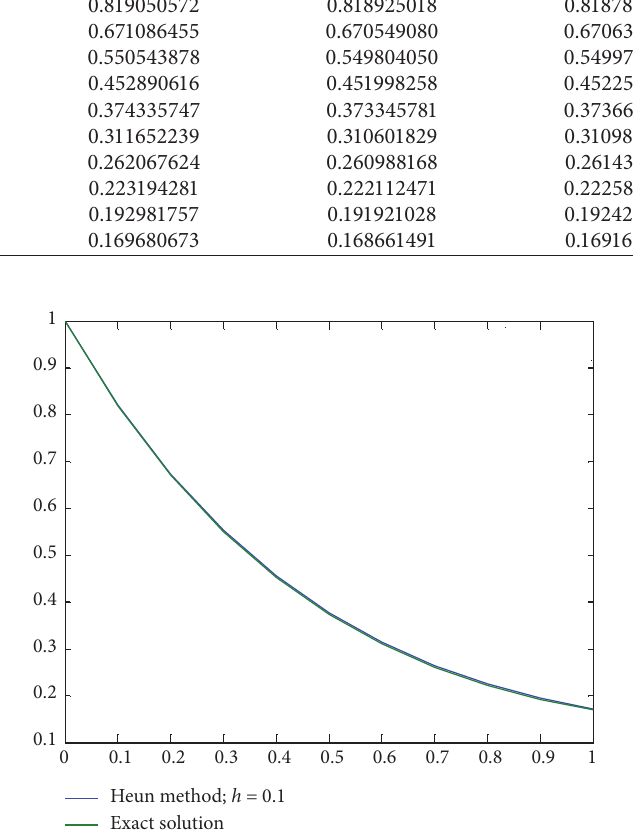
Figure 2: Numerical solution using Heun’s method and exact solution for Example 1.